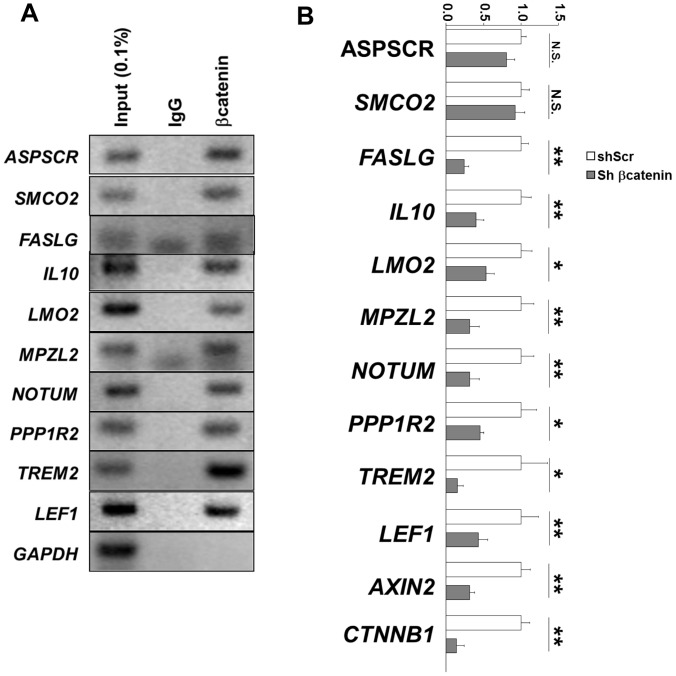
Validation of CTNNB1 direct target genes.
A. ChIP-PCR analysis of the indicated genes using an independently prepared chromatin sample. LEF1 and GAPDH serve as positive and negative controls, respectively. B. Quantitative RT-PCR of the indicated genes. Mean ± standard deviation of 4 independent experiments are shown. p values are calculated with two-tailed standard t-test. N.S.: not significant, *: p<0.05, and **: p<0.01.